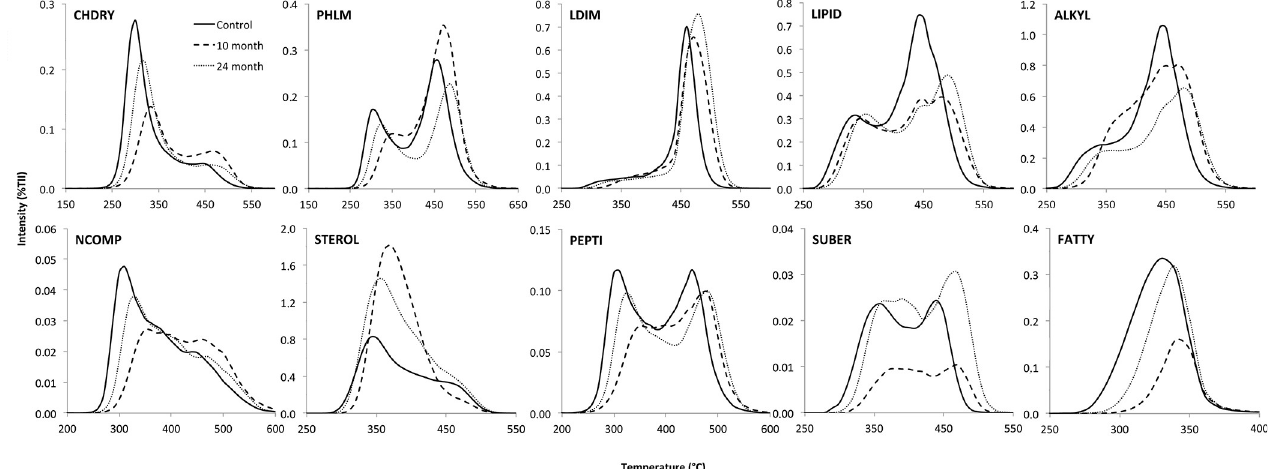
Fig 2. Pyrolysis field thermogram of the compound classes CHYDR, carbohydrates; PHLM, phenols and lignin monomers; LDIM, lignin dimers; LIPID, long-chained hydrocarbons; ALKYL, alkylaromatics; NCOMP, N-containing non-peptidic compounds; STEROL, sterols; PEPTI, peptides; SUBER, suberin; and FATTY, free fatty acids C16-C34 normalized to the total ion intensity (TII) of samples for the control without clear-cut, 10, and 24 month after clear-cut. Peaks at higher temperatures indicate higher thermal stability.